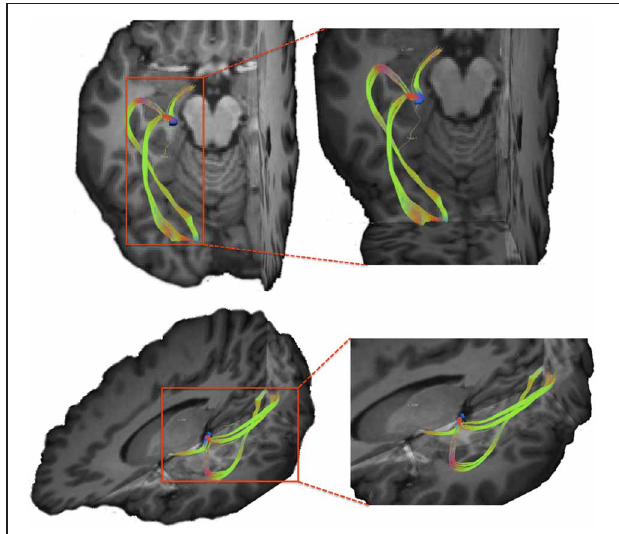
FIGURE 6 | Visual pathways resulting from tracking between lateral geniculate nucleus (LGN) and the occipital cortex. We note that using our tracking technique we are able to resolve both superior and inferior branches of the optic radiations originating within the